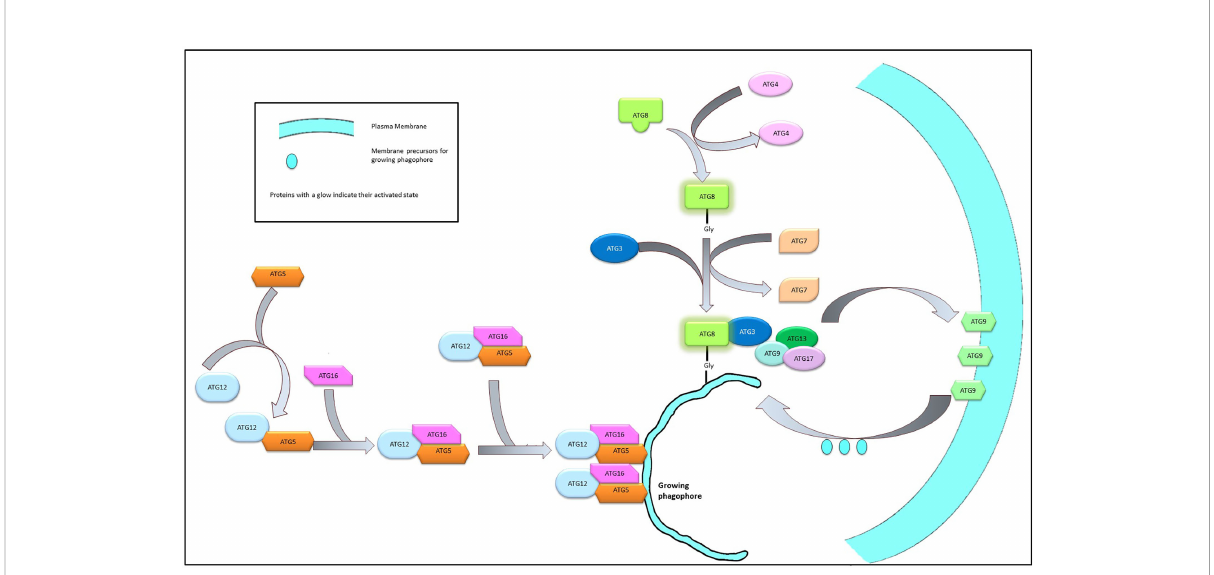
FIGURE 4 Elongation of phagophore membrane. Dimerization of the Atg12-Atg5-Atg16 complex on the surface of the growing phagophore membrane promote the recruitment of Atg8 and Atg9 complex on the growing membrane. Atg9 imports membrane components from the neighboring bio-membranes to the growing phagophore to facilitate